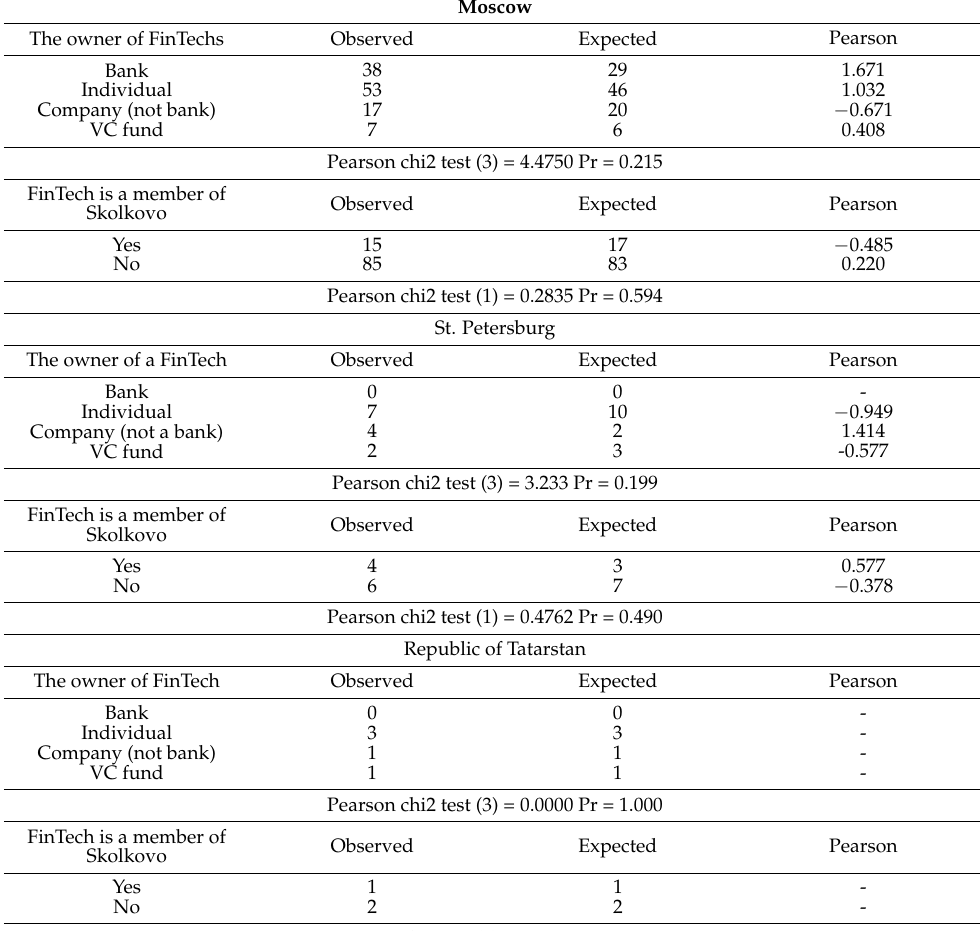
Table 5. Comparison of sample and original